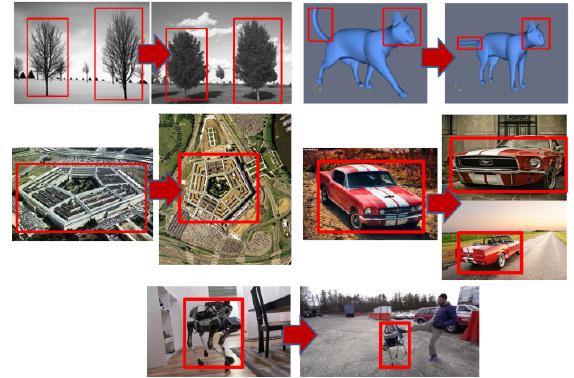
Figure 1. Semantic matching as image matching with major shape and/or pose